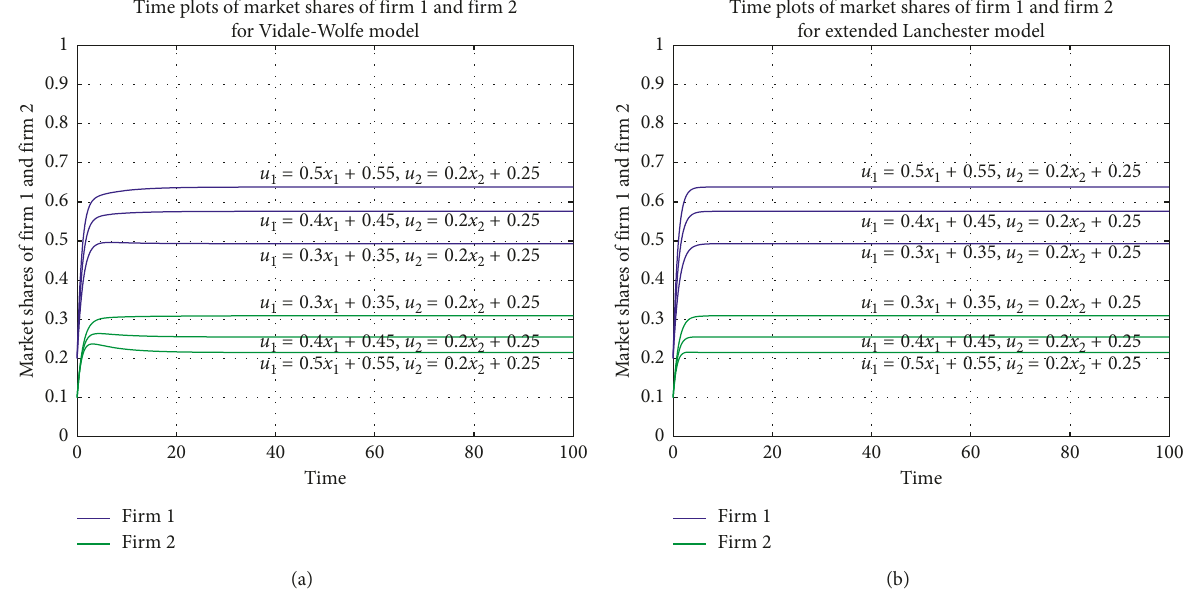
Figure 4: Evolution of market shares of firms x (20) and (b) extended Lanchester model expressed in equation